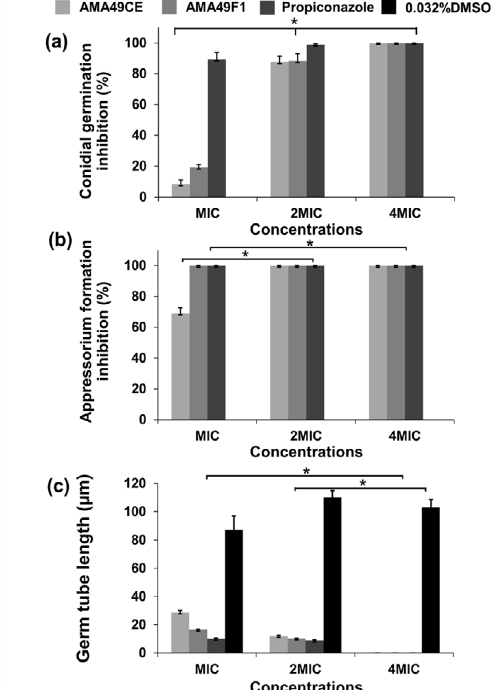
Fig. 2. The effect of extracts AMA49CE and AMA49F1 from Streptomyces sp. AMA49 on P. oryzae PTRC1 condia at 1xMIC (8µg/ml), 2xMIC (16µg/ml) and 4xMIC (32µg/ml) after 24 h incubation anaylsed by two-way ANOVA and Turkey HSD post-hoc test. Propiconazole and DMSO were used ad positive and negative controls, respectively. The data represent mean values based on three replicates in each treatment. Error bars indicate the ± SE. (* P ≤ 0.001; main effect of concentration. (a) condial germination inhibition, (b) appressorium formation inhibition, (c) germ tube